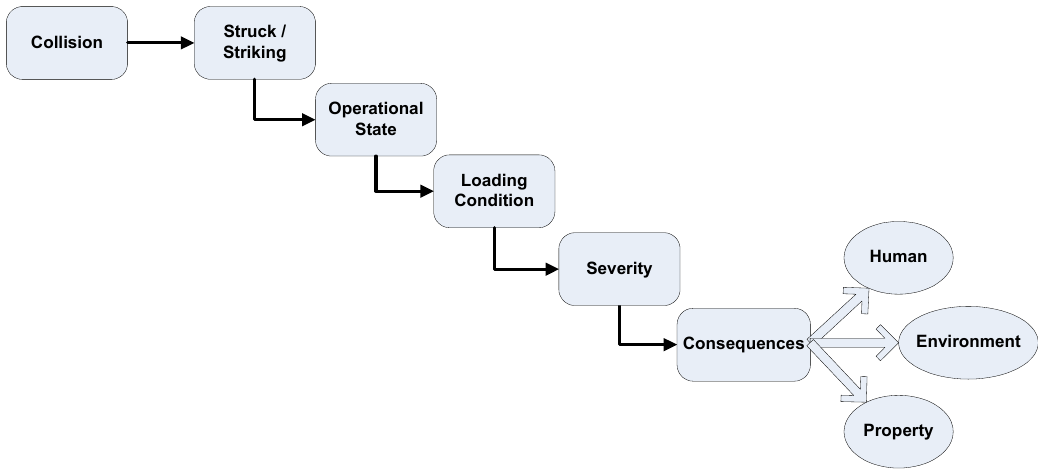
Figure 7. High level accident sequence for accident category